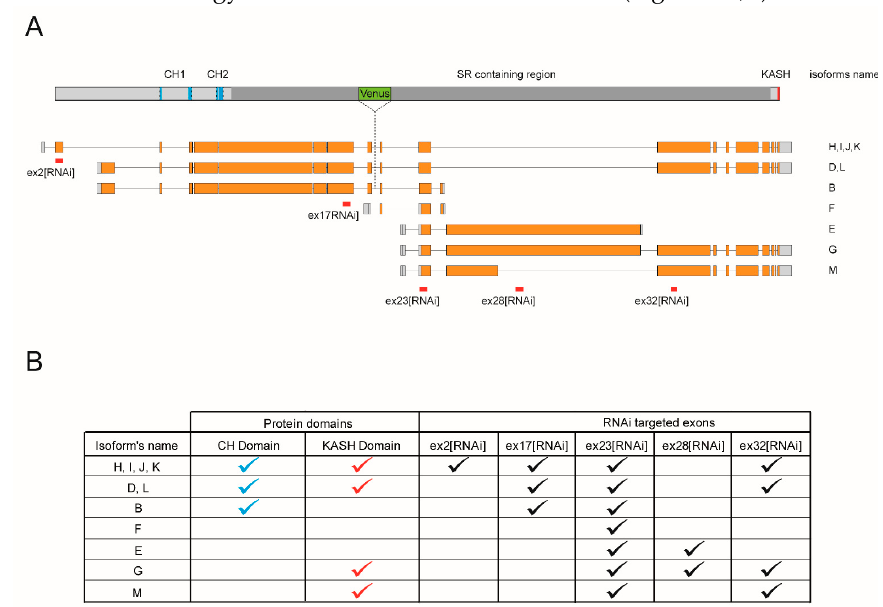
Figure 1. Msp300 isoforms. ( A ) Schematic representation of Msp300 isoforms. Isoform diversity results from the use of different start and stop exons (respectively exon 1, 3, 18 and 21 for the start and exon 26, 29, 40 and 41 for the stop) but also from alternative splicing events. For simplicity, isoforms H, I, J and K, all starting at exon1 and containing the C-terminal KASH domain have been represented as a single transcript despite the use of few alternative exons within the coding sequence (top transcript). Similarly, isoforms D and L differ by one alternative splice event and have been represented by a single transcript (second top transcript). Isoform M is represented here although RNAseq tissue-specific analysis suggests that it is not expressed in larval muscle [27]. Exon structure is represented at scale (coding region in orange, non-coding in grey). RNAi amplicons are shown in red under the targeted exon. ex32[RNAi] was used in a previous work and positioned here for discussions sake. Protein features are positioned above the isoforms schemes: Calponin Homology domains (CH) are shown in blue, KASH domain in red, the region containing the Spectrin Repeats (SR) in dark grey and the protein-trap transposon used in this study in green (based on Flybase, http://flybase.org/reports/FBgn0261836, accessed on 6 May 2021). ( B ) Table summarising the structure of isoforms and RNAi targets.